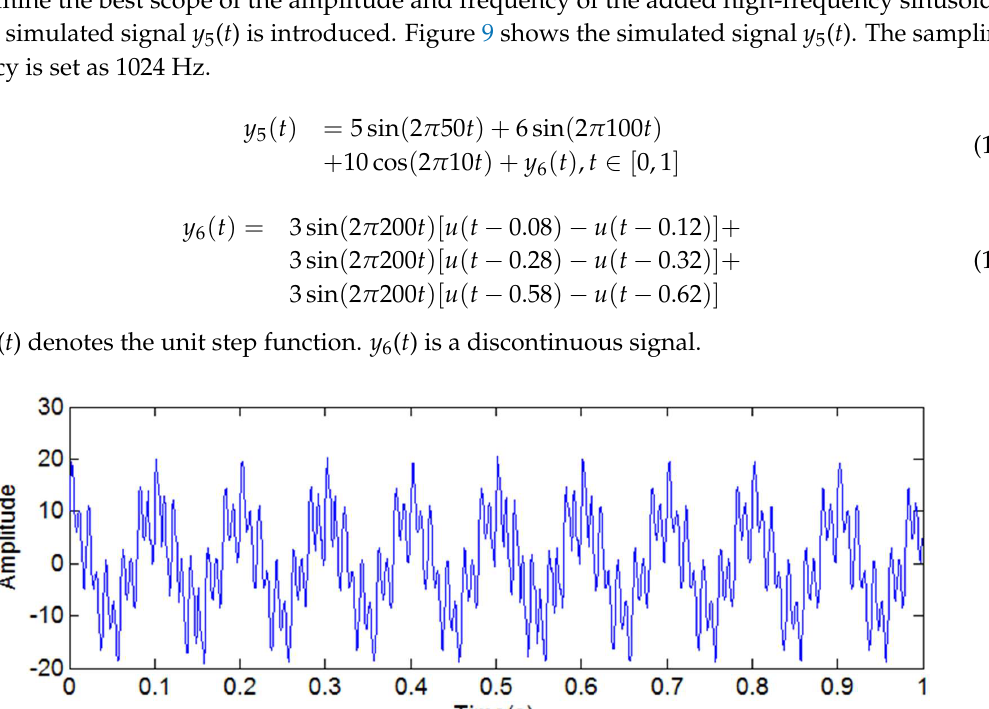
Figure 10. The distribution of the NMSE. ( a ) The three-dimensional distribution of the NMSE; ( b ) The distribution plan of the NMSE.